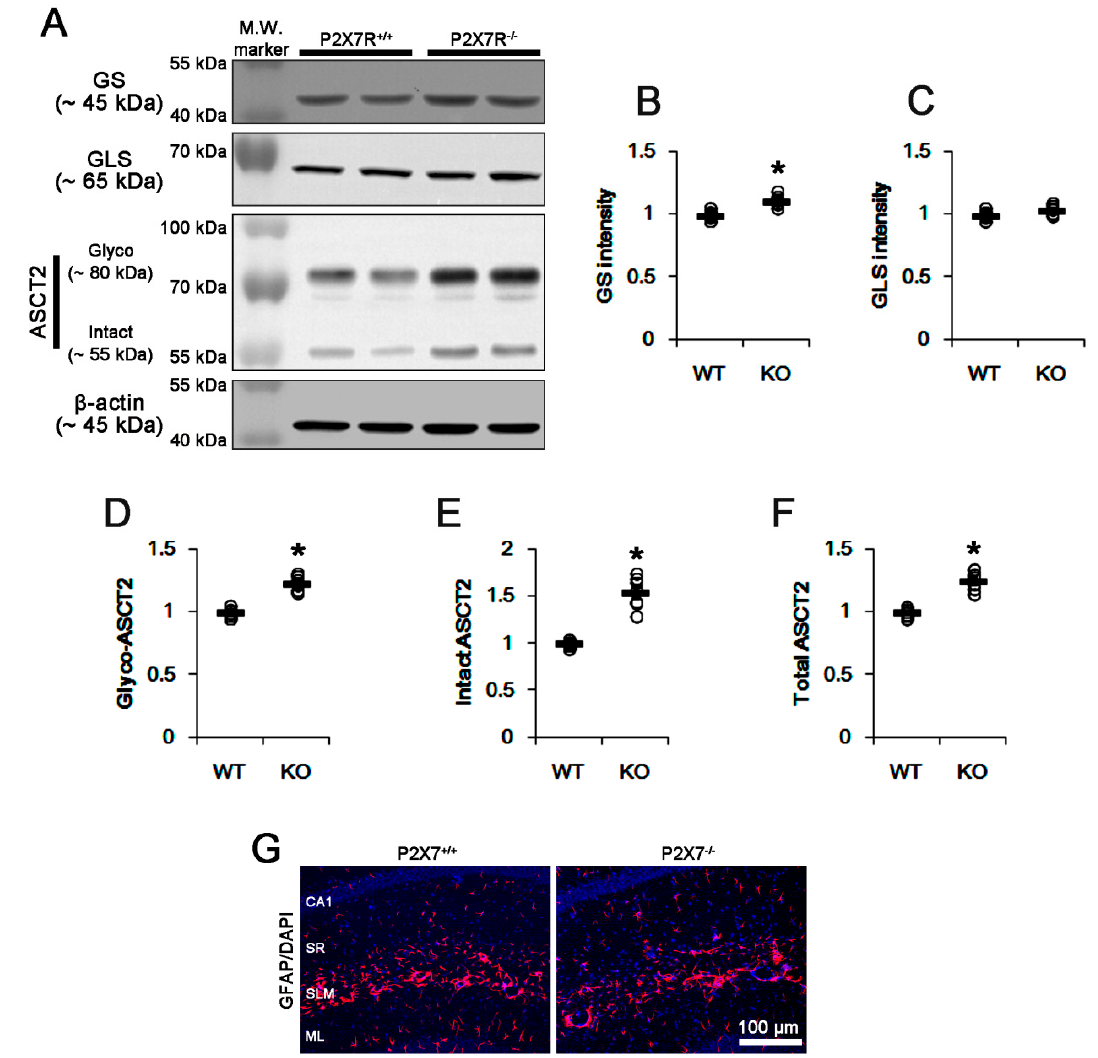
Figure 1. E ff ects of P2X7R deletion on expressions of glutamine synthase (GS), glutaminase (GLS), a glutamine:cysteine exchanger (ASCT2) and glial fibrillary acidic protein (GFAP). P2X7R deletion increases GS and ASCT2, but not GLS, expressions. ( A ) Representative Western blots of GS, GLS and ASCT2 expressions. ( B – F ) Quantification of GS ( B ), GLS ( C ), glycosylated ASCT2 (Glycol-ASCT2, D ), intact ASCT2 ( E , F ) total ASCT2 levels based on Western blot data. Open circles indicate each individual value. Horizontal bars indicate mean value (mean ± S.E.M.; * p < 0.05 vs. WT animals; n = 7, respectively). ( G ) Representative photos for GFAP expression in the hippocampus. P2X7R deletion does not result in reactive astrogliosis in the hippocampus. Abbreviations: CA1, CA1 pyramidal cell layer; SR, stratum radiatum; SLM, stratum lacunosum-moleculare; ML, molecular layer of the dentate gyrus.